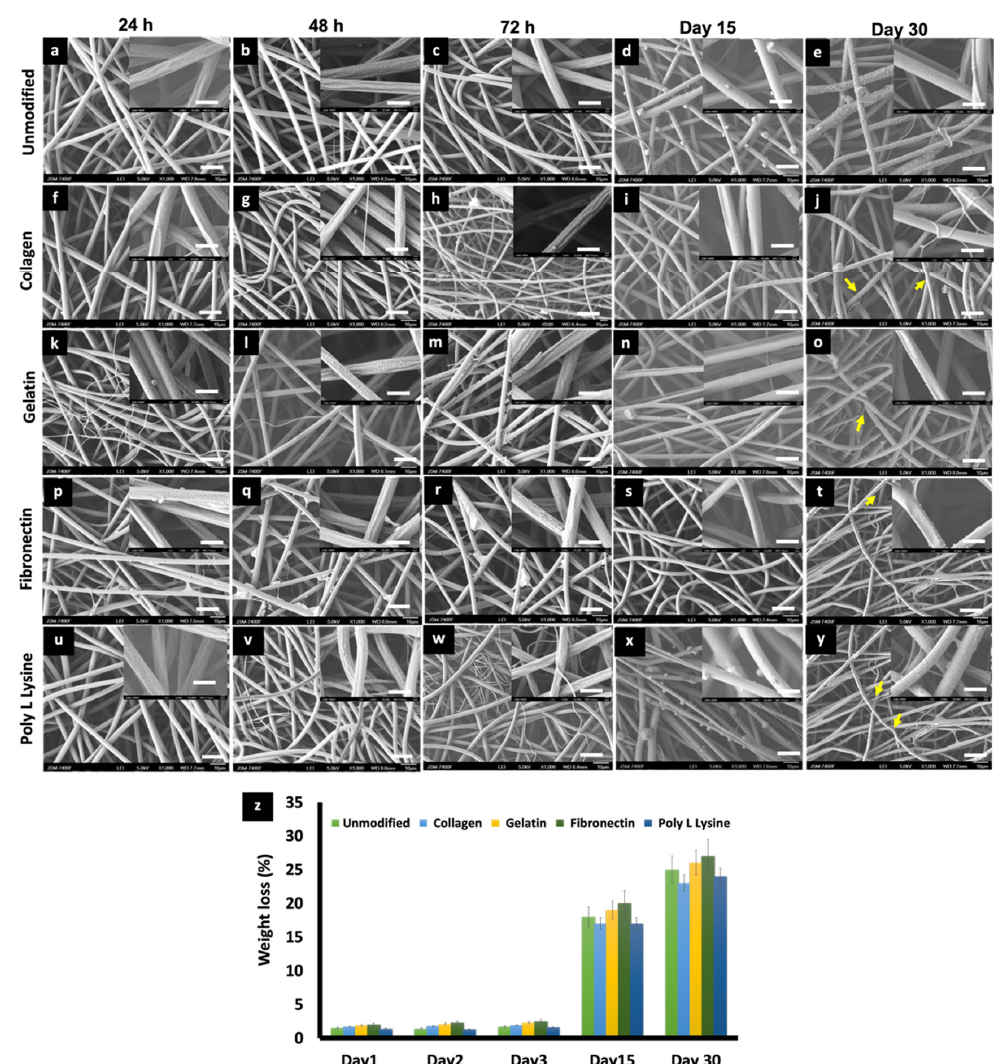
Figure 7. SEM micrographs depicting the changes in morphology of ( a ) 24 h, ( b ) 48 h, ( c ) 72 h, ( d ) Day 15, ( e ) Day 30 PLLA unmodified, ( f ) 24 h, ( g ) 48 h, ( h ) 72 h, ( i ) Day 15, ( j ) Day 30, PLLA collagen, ( k ) 24 h, ( l ) 48 h, ( m ) 72 h, ( n ) Day 15, ( o ) Day 30, PLLA gelatin, ( p ) 24 h, ( q ) 48 h, ( r ) 72 h, ( s ) Day 15, ( t ) Day 30, PLLA fibronectin and ( u ) 24 h, ( v ) 48 h, ( w ) 72 h, ( x ) Day 15, ( y ) Day 30. PLLA poly L lysine electrospun scaffolds after being immersed in PBS 7.4 for different time point at 37 ◦ C at Day 0, Day 2, Day 3, Day 15, Day 30. (scale bar=10 μ m). Inset images are magnifications of the corresponding surface (scale bar=1 μ m). Salt crystal accumulation on the fiber surface can be observed along with the thinning of fibers due to gradual degradation after 30 days of incubation in PBS. (indicated by yellow arrows) ( z ) Weight loss percentage of electrospun PLLA and different protein functionalized scaffolds during 30 days of degradation in phosphate buffer saline (PBS).